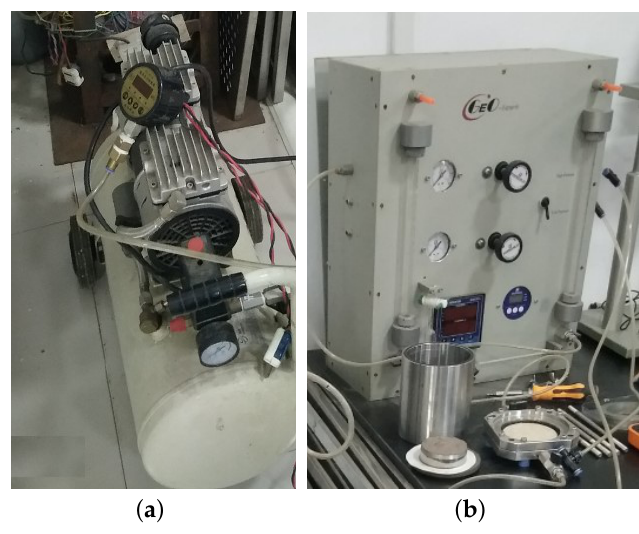
Figure 5. Pressure plate instrument: ( a ) pump; ( b ) pressure gauge.